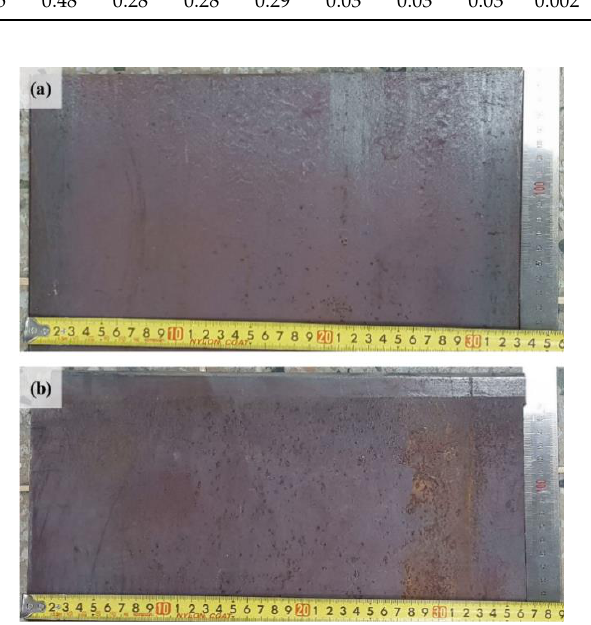
Figure 1. Surface morphology of steel plates after direct quenching process: ( a ) alloy A (5T) and ( b ) alloy B (15T).